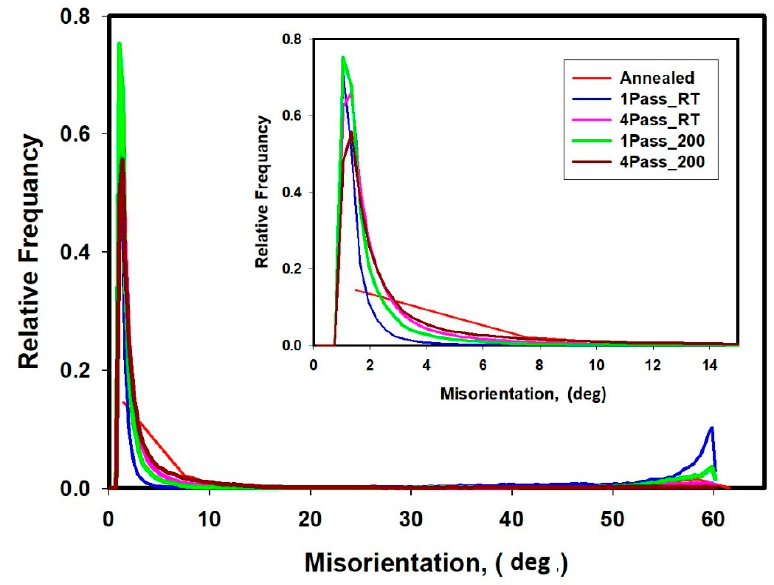
Figure 12. Relative frequency of the misorientation angle distribution of AA commercial pure Cu and after ECAP processing for 1-P and 4-Bc.